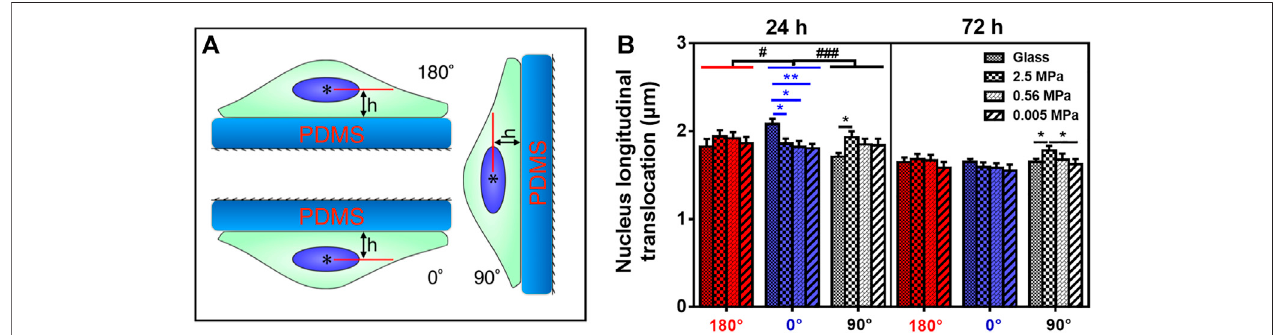
FIGURE1| Nucleustranslocationofratbonemarrow-derivedstemcells(rMSCs)ondifferentstiffnessinthreeorientedsubstrates. (A) SchematicofrMSCsplaced ontopoly-dimethylsiloxane(PDMS)substrateat180 ° ,0 ° ,or90 ° .Theangleisde fi nedastheonebetweentheouternormalvectorofthesubstrateandthegravityvectorin respectiveorientation,and h isthedistancebetweenthenucleuscentroid(*)tothesurfaceofthesubstrate. (B) NucleuslongitudinaltranslocationofrMSCsontooriented glass or PDMS substrate with three stiffness substrates. Data were presented as mean ± SE of ~45 cells from three repeated experiments at 24 or 72 h. * or **, t -test, p < 0.05 or 0.01; # or ### , two-way ANOVA test for different groups with different stiffness substrates with cell orientation, p < 0.05 or